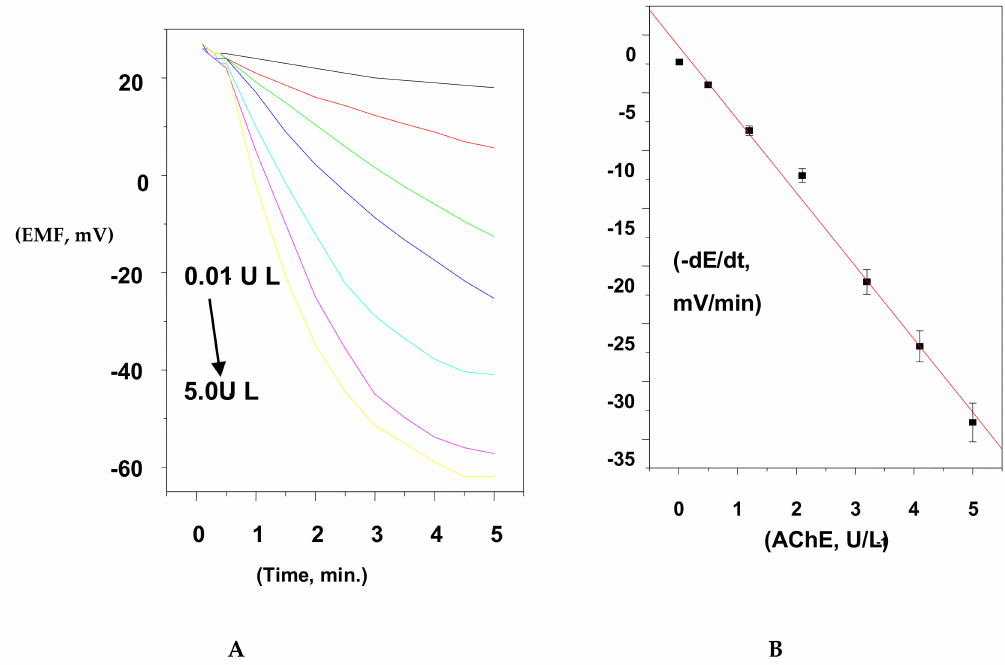
Figure 7. ( A ) Hydrolysis of ACh substrate using the initial rate method at 25 ◦ C; ( B ) the calibration curve constructed for AChE